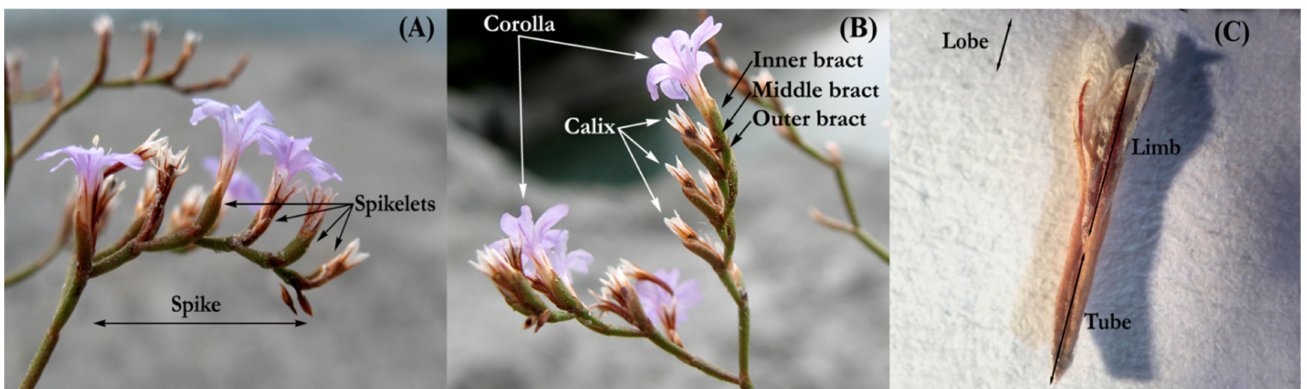
Figure 2. Inflorescence architecture ( A ) and floral parts ( B , C ). Picture refers to Limonium pontium s.str